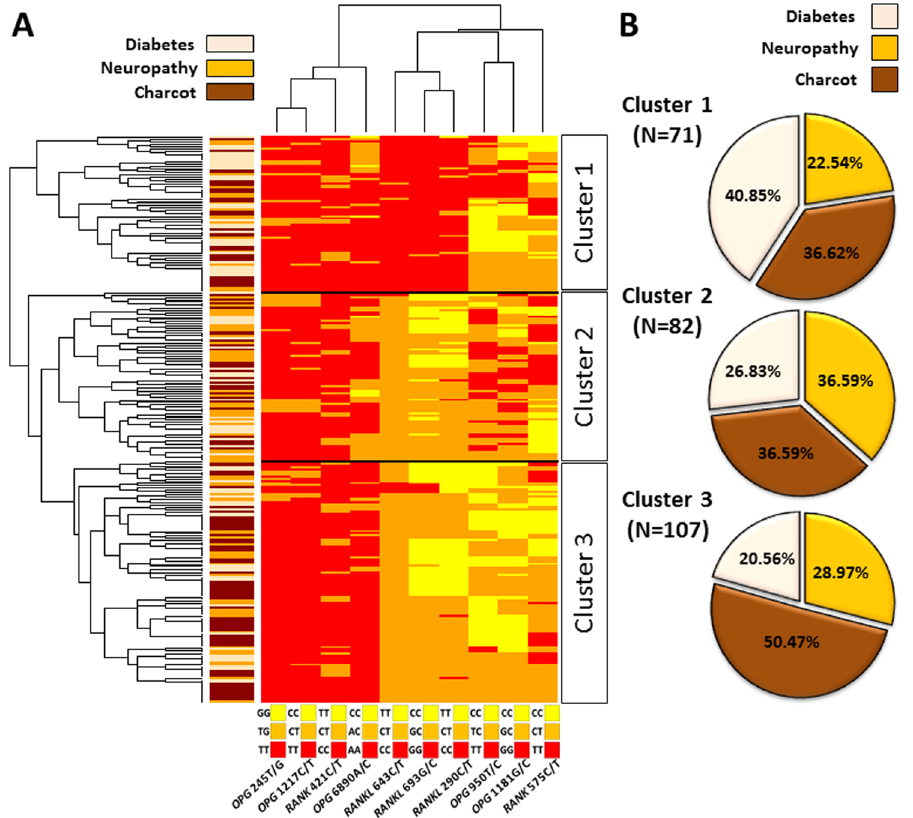
Figure 4. Hierarchical clustering of SNPs in OPG , RANKL and RANK genes. ( A ) Distribution of SNPs in selected genes is shown as a heat map where colors correspond to homozygote or heterozygote, accordingly to the legend for each SNP (below the heat map). Row dendrogram shows patient SNP profile clusters and column dendrogram shows distribution pattern of selected SNPs across all patients. Side bar color corresponds to a group according to the legend above the bar. 260 patients have been divided into three clusters according to the similarities in their SNPs’ profiles. ( B ) Percentage of patients diagnosed with diabetes, neuropathy or Charcot arthropathy in the corresponding clusters. The legend is shown above the pie charts. Numbers in brackets below the percentage show the number of patients from each